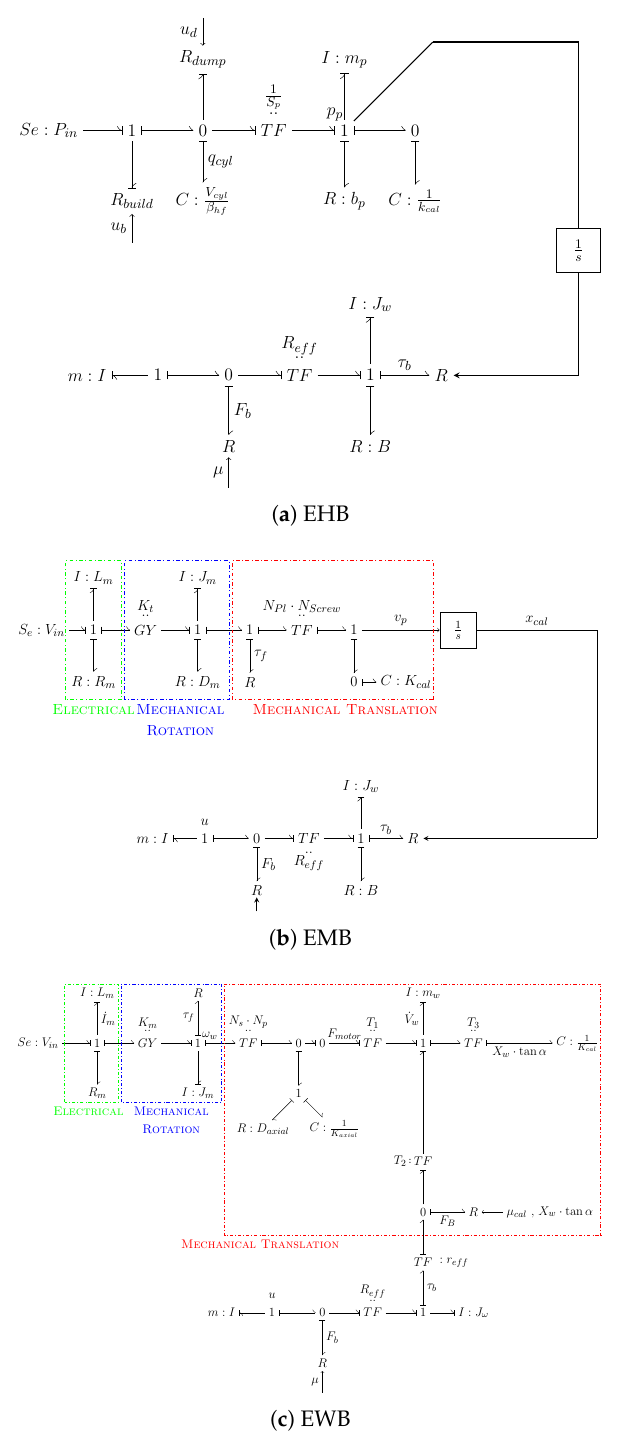
Figure 2. Bond graphs of brake-by-wire